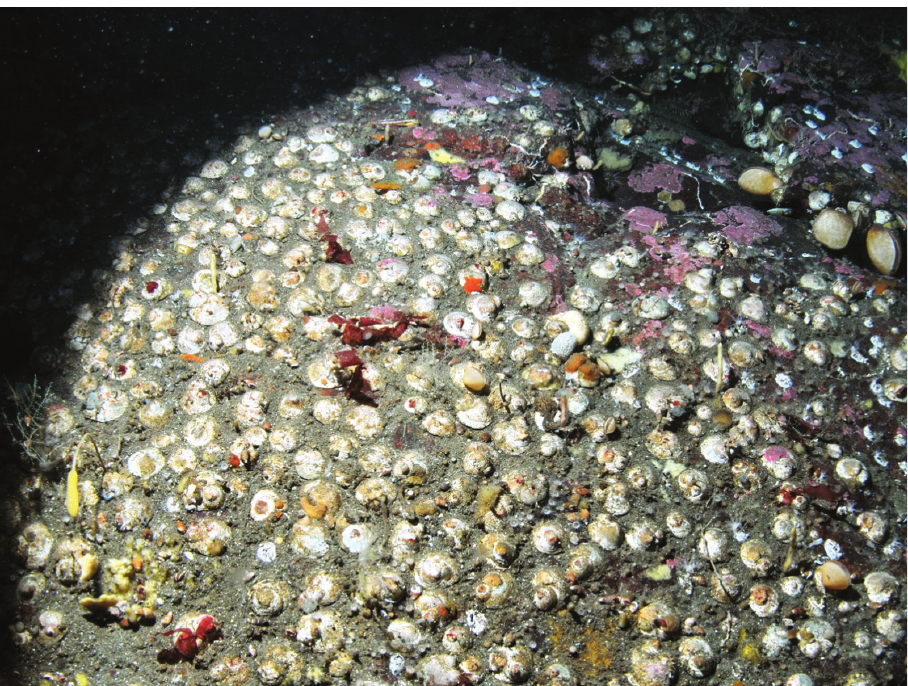
Figure 1. High densities of Calyptraea aurita in a depth of 34 m mean tide level at Caleta la Arena (Reloncaví